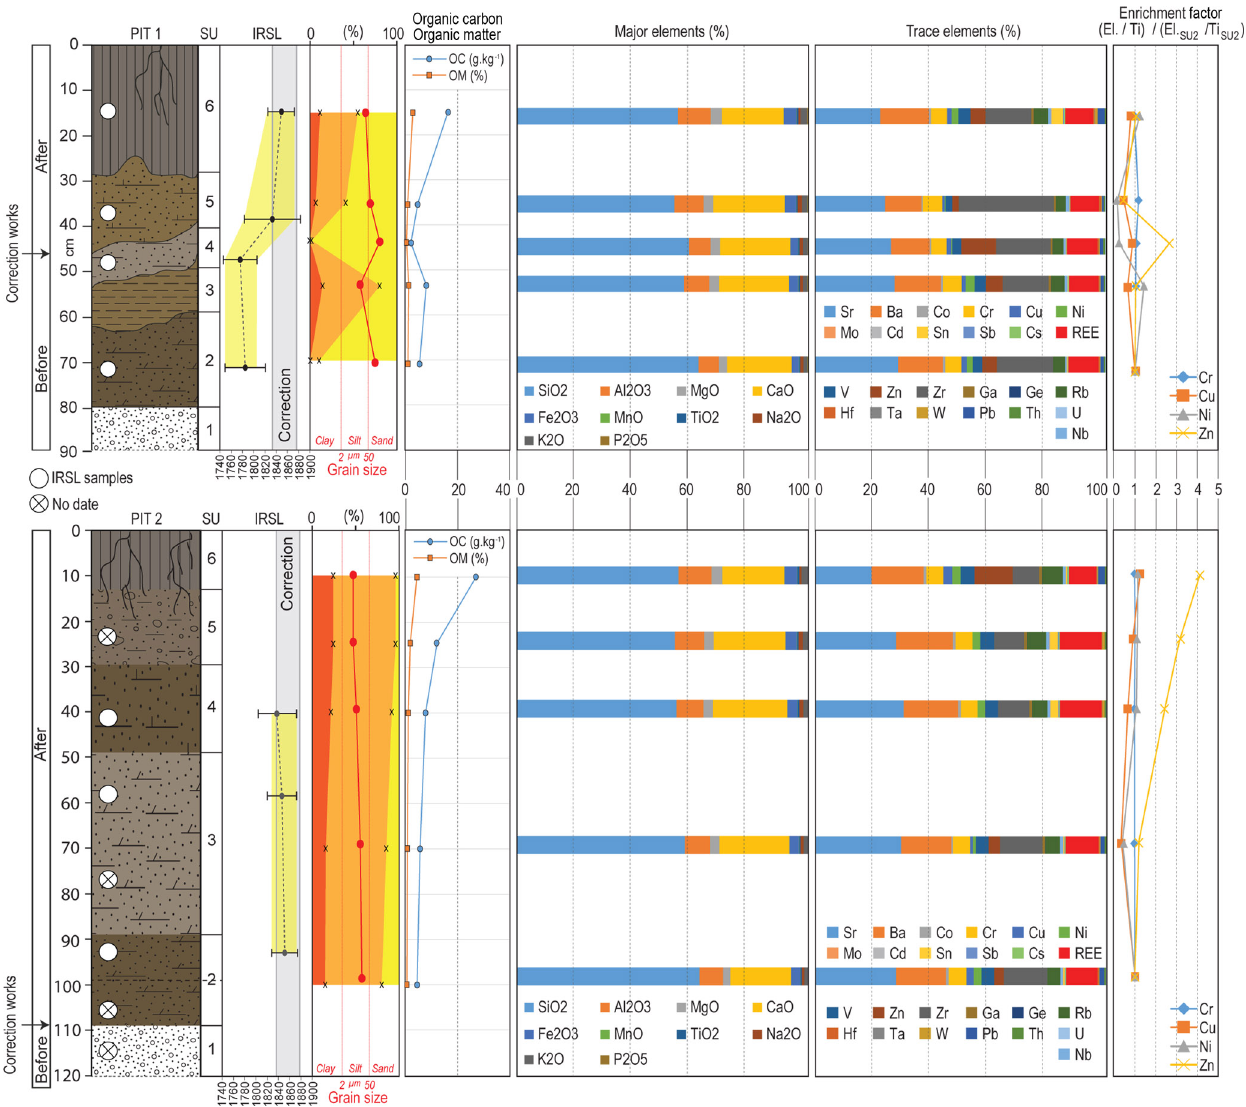
Figure 7. Stratigraphical log of the two pits including datings, organic contents, and sedimentological and geochemical